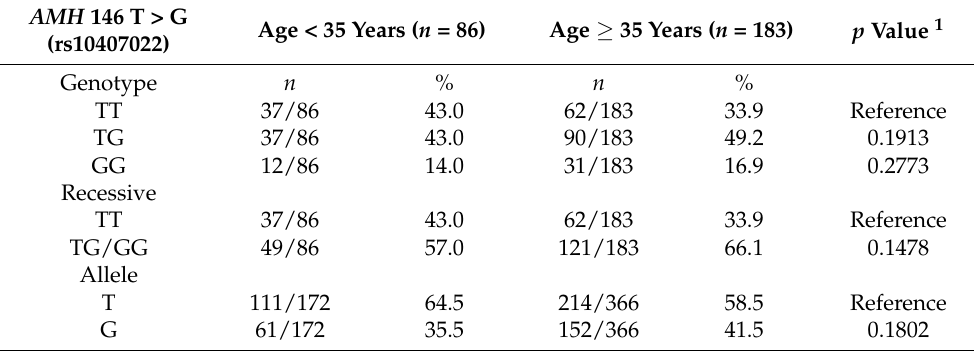
Table 2. The frequencies of AMH 146T > G (rs10407022) SNP among women with serum AMH < 1.2 ng/mL in varied age groups.